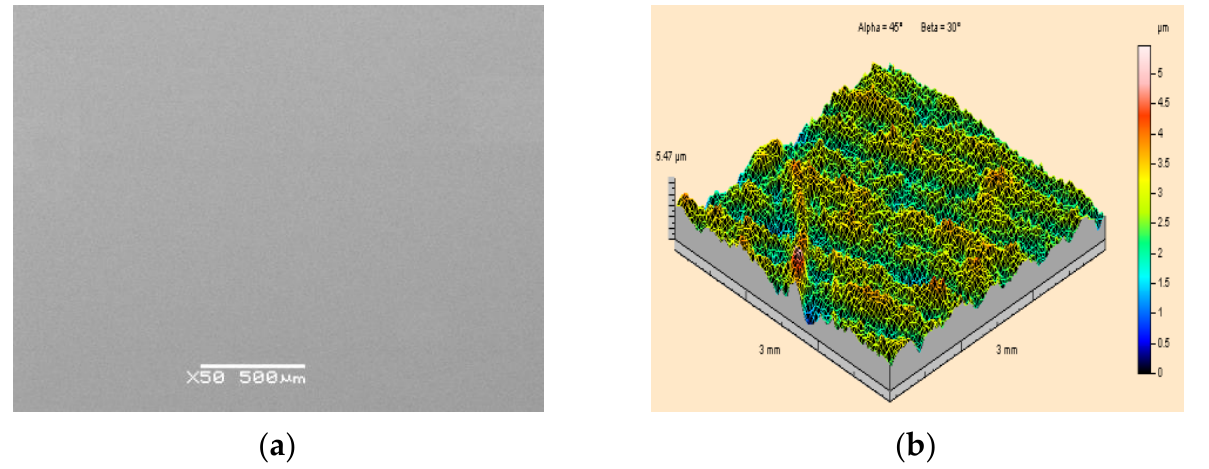
Figure 8. View of the surface of a polymethyl methacrylate PMMA specimen prior to the application of a paint coating and prior to high-pressure water-ice jet treatment: ( a ) Scanning electron microscope image (50×magnification); ( b ) Isometric image.